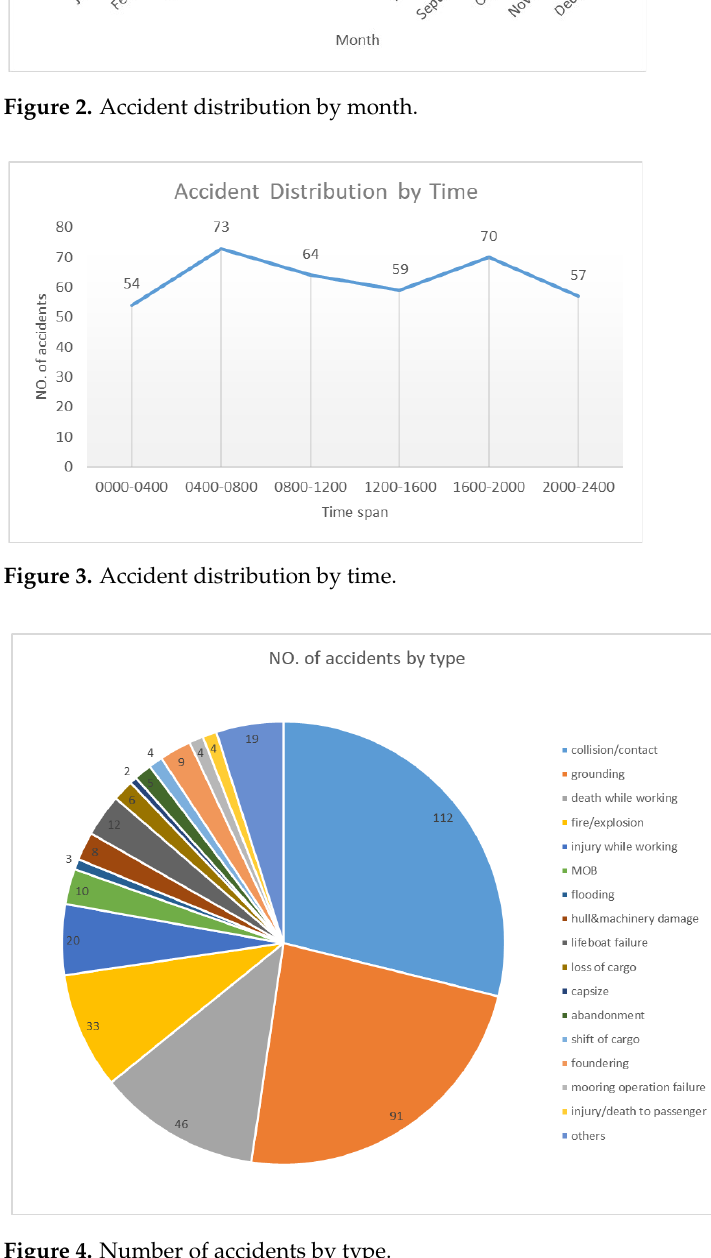
Figure 2. Accident distribution by month.